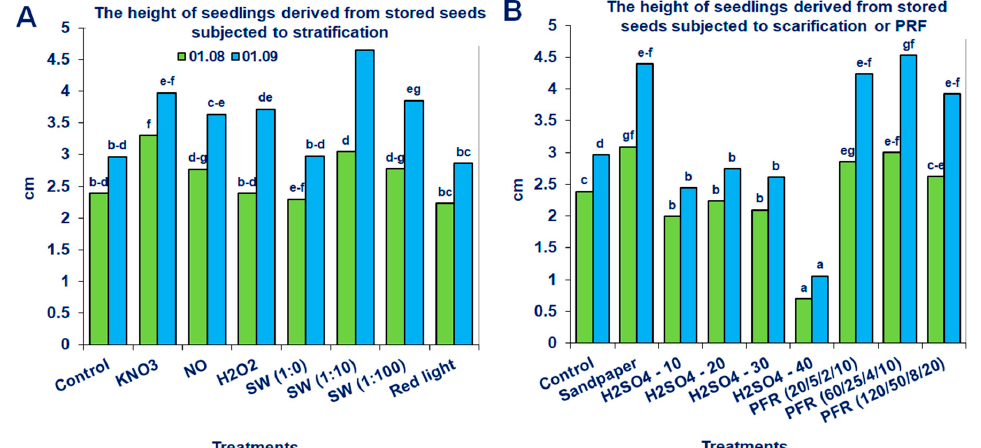
Figure 6. Saskatoon berry seedling heights derived from stored seeds subjected to ( A ) stratification (3 ◦ C) in the presence of KNO 3 , NO, H 2 O 2 , smoke-water (SW, in concentrations 1:1, 1:10, 1:100), red light or 20 ◦ C/3 ◦ C or ( B ) scarification: sandpaper, sulfuric acid for 10, 20, 30 and 40 min, or treatments with pulsed radio frequency (PRF, 20/5/2/10, 60/25/4/10, 120/50/8/20). The data within the graph ( A or B ) and the color of the bar and with the same letter do not differ significantly according to Tukey’s test (5%). Values are the means of three replications of 50 seeds.